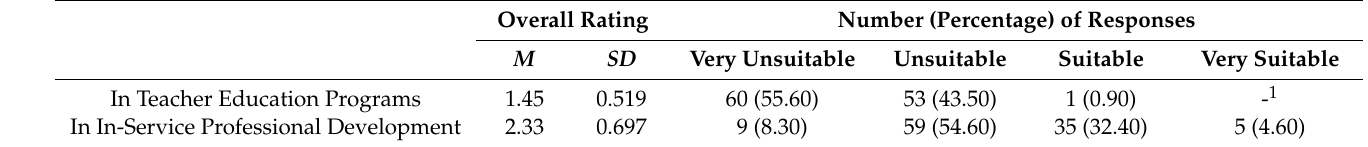
Table 4. Overall Rating ( N = 108) about Evidence-Based Social-Communication Focused Practice in Teacher Education Programs and In-Service Professional Development.